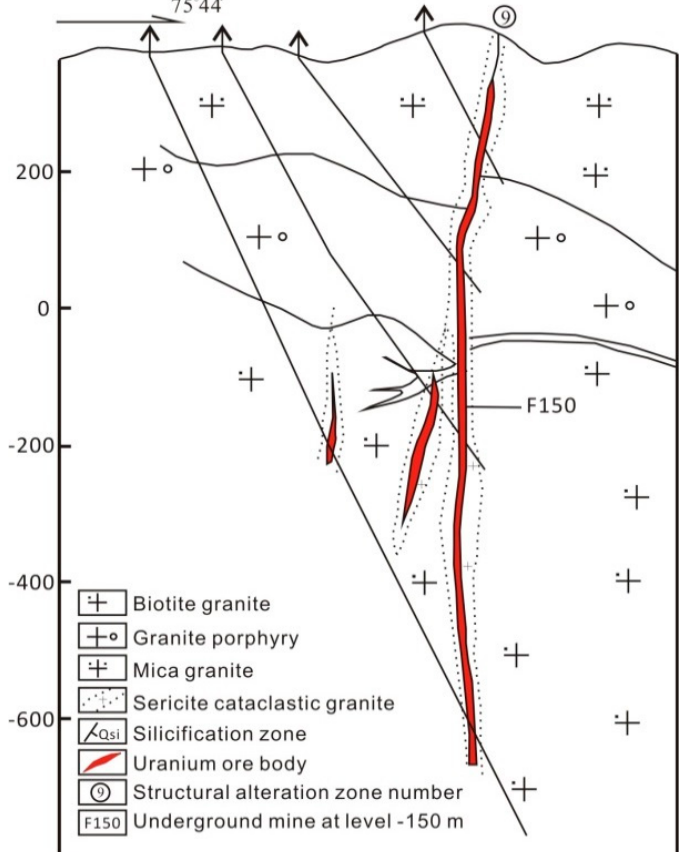
Figure 3. Schematic map of U-mineralized alteration zone No. 9 in the Mianhuakeng U deposit (revised from Qi et al. [19]).